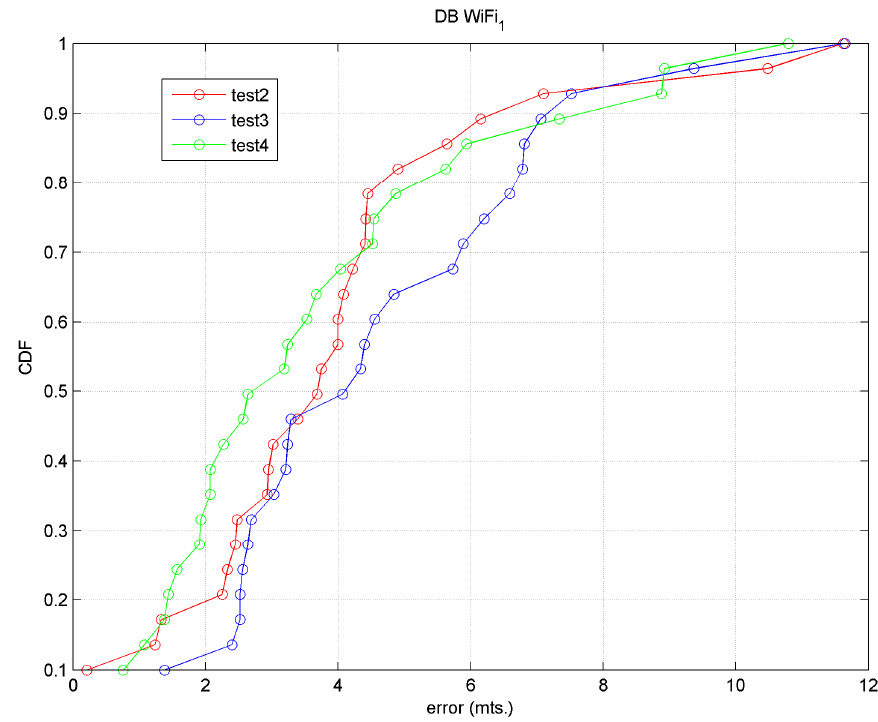
Figure 13. Precision (CDF) for Test 2, Test 3 and Test 4.